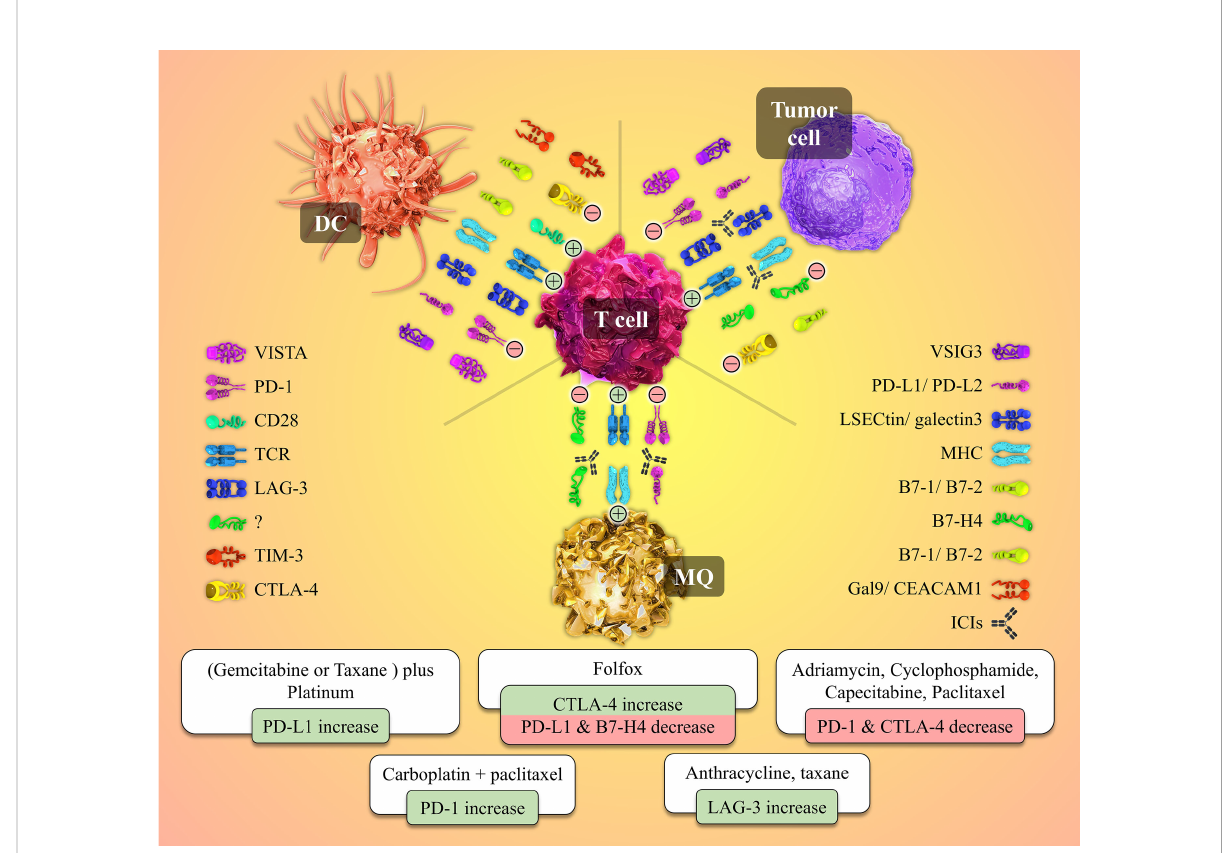
FIGURE 2 Cell to cell interactions and the role of the immune-checkpoint molecules and their receptors in the tumor microenvironment besides the patterns of immune-checkpoints expression patterns ’ changes post-NAC with different chemotherapeutic agents. Tumor site T-cells need two activating signals to defend against and kill the tumor cells (shown by plus mark in a circle). The fi rst signal is provided by the interaction between the T cell receptor (TCR) and its speci fi c antigen presented by the MHC molecule on the Antigen-presenting cells (APCs) or the tumor cell. The second signal is a co-stimulatory one originating from CD28 and B7-1/B7-2 molecules interaction. Tumor cells overexpress inhibitory immune checkpoints to produce inhibitory signals and neutralize the positive ones (shown by the negative mark in a circle). Immune checkpoint inhibitors (ICIs), as a wide variety of drugs used in the immunotherapy of cancers, block the mentioned co-inhibitory function of the checkpoint molecules. Different chemotherapeutic agents alter the expression patterns of immune-checkpoint molecules by whether down-regulating or up-regulating the expression of these immune